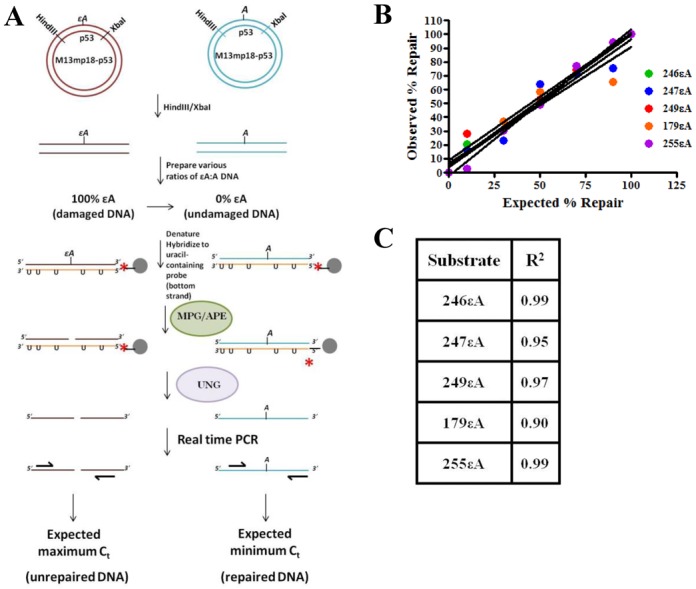
Experimental design and method validation by mixing experiment in vitro. (A) Schematic representation of repair assay. (B) 246εA, 247εA, 249εA, 179εA and 255εA mixing experiment demonstrating the linearity of the assay. (C) Table reports the R2 values of the trendline for each mixing experiment graphed in (B).